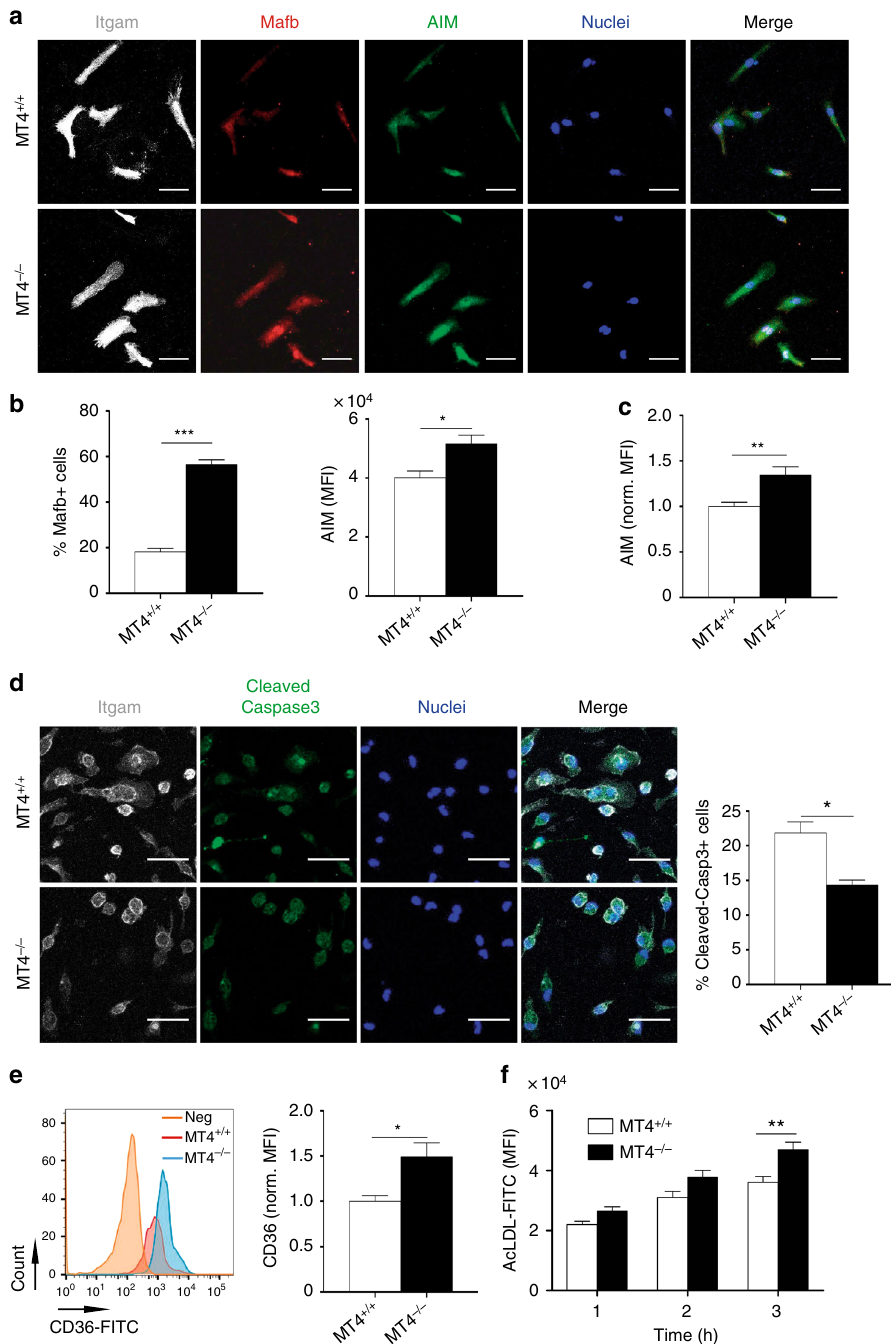
Fig. 7 MT4-MMP-null Mafb + /AIM + peritoneal macrophages exhibit above-normal CD36 at the cell surface and enhanced acLDL binding. a Representative images of MT4-MMP + / + (MT4 + / + ) or MT4-MMP – / – (MT4 − / − ) mouse peritoneal macrophages elicited by 72 h TG stimulation and labeled for Itgam (white), Mafb (red), and AIM (green), and with Hoechst (blue, nuclei); scale bar, 20 µ m. b Graphs show the percentage of cells Mafb + in the nuclei (left) and the MFI of AIM within Mafb + cells (right); n = 6 in two independent experiments. c Quanti fi cation of normalized MFI of AIM analyzed by fl ow cytometry in MT4 + / + or MT4 − / − mouse peritoneal macrophages elicited by 72-hour TG stimulation; n = 6 in two independent experiments. d Representative images of TG-elicited MT4 + / + or MT4 – / – mouse peritoneal macrophages treated with cycloheximide (100 μ g ml − 1 ) for 6 h and labeled for Itgam (white) and cleaved-caspase 3 (green) and Hoechst (blue, nuclei); scale bar, 20 µ m. Quanti fi cation of the percentage of cleaved-caspase 3-positive cells is shown on the right; n = 3 in one experiment. e Representative fl ow cytometry histogram plot of CD36 staining in TG-elicited MT4 + / + or MT4 – / – mouse peritoneal macrophages (left) and quanti fi cation of normalized MFI (right); n = 6 in two independent experiments. f MFI of AcLDL-FITC binding to TG-elicited MT4 + / + or MT4 – / – mouse peritoneal macrophages for the indicated times; n = 6 in two independent experiment. Data were tested by Student ’ s t -test in b , c , d , and e , and by two-way ANOVA followed by Bonferroni ’ s post test in f . Results are expressed as mean ± SEM. * p < 0.05, ** p < 0.01, and *** p <